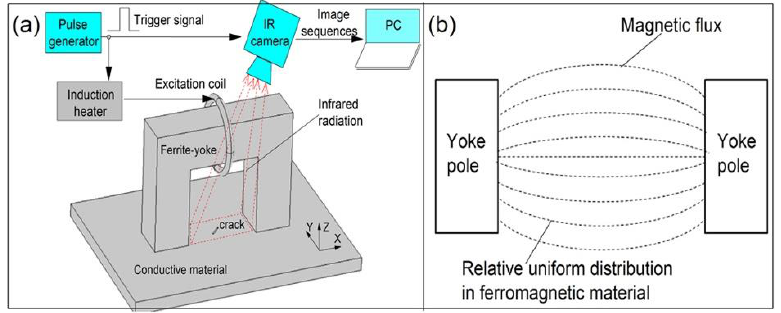
Figure 3. Proposed ferrite-yoke-based configuration of ECPT. ( a ) Schematic diagram of ferrite-yoke- based ECPT system. ( b ) Magnetic flux distribution in ferromagnetic material between yoke poles.